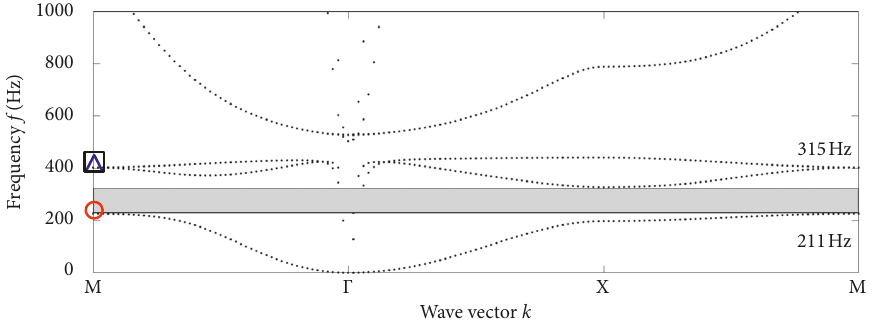
Figure 10: Dispersion curve under type 4.